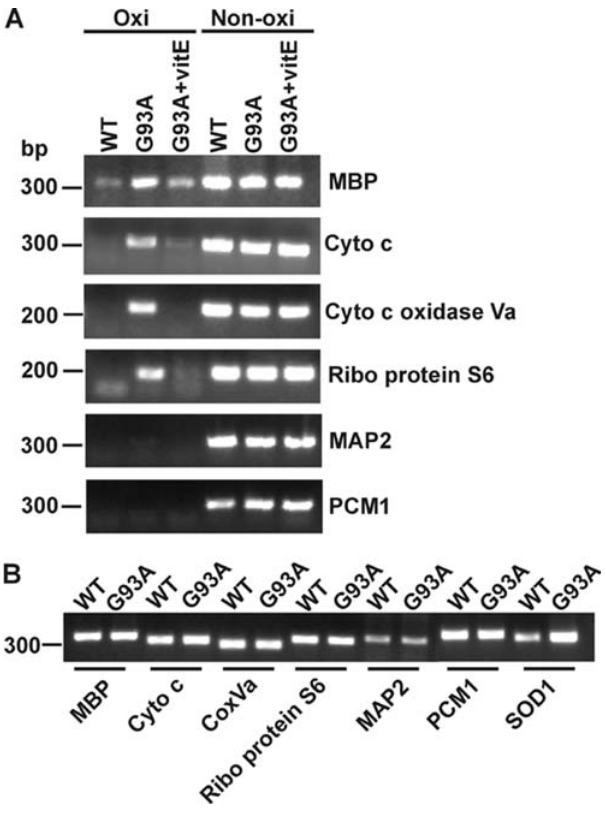
Figure 4. Some mRNA species are more susceptible to oxidative damage in SOD1 G93A mice. ( A ) Semi-quantitative RT- PCR analysis confirmed that the identified mRNA species by DNA microarray were present in the oxidized mRNA pool. MBP, cytochrome c, cytochrome c oxidase Va and ribosome protein S6 mRNAs, which had strong signal intensities on the arrays, were present in the oxidized mRNA pool. MAP2 and PCM1 mRNAs, which had very weak signal intensities on the arrays, were hardly detected in the oxidized mRNA pool. These oxidized mRNA species are significantly decreased in vitamin E treated SOD1 G93A mice ( G93A + vitE ). ( B ) Semi-quantitative RT- PCR analysis showed that the oxidized mRNA species are not upregulated in the whole spinal cord of SOD1 G93A mice compared to their non-transgenic littermates. SOD1 mRNA, which includes endog- enous mouse SOD1 and transgenic human SOD1, was used as a control. n=3.